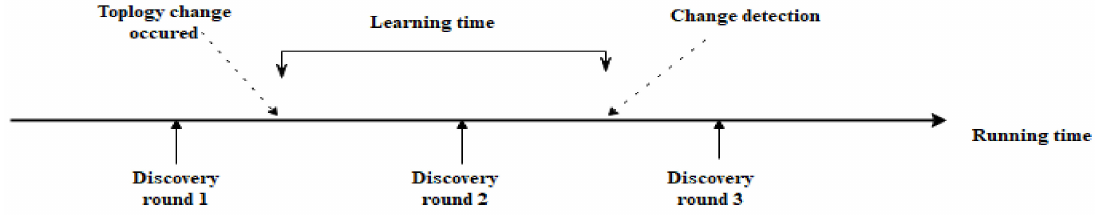
Figure 7. Learning time between rounds of topology discovery.